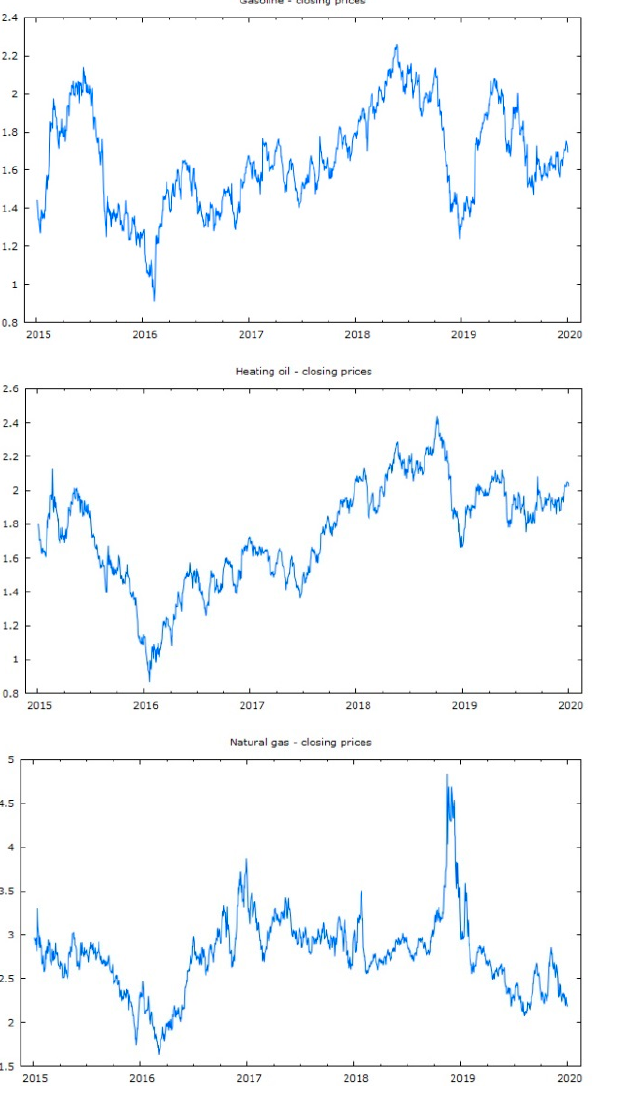
Table 1. Summary statistics of daily returns, squared returns and values of the Parkinson estimator. Commodities Mean